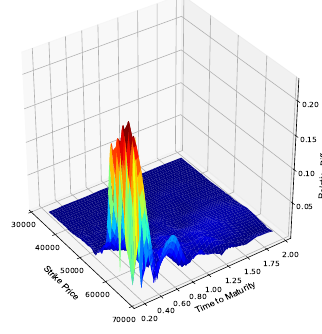
Figure 6. JSE Top 40 zero collateral call